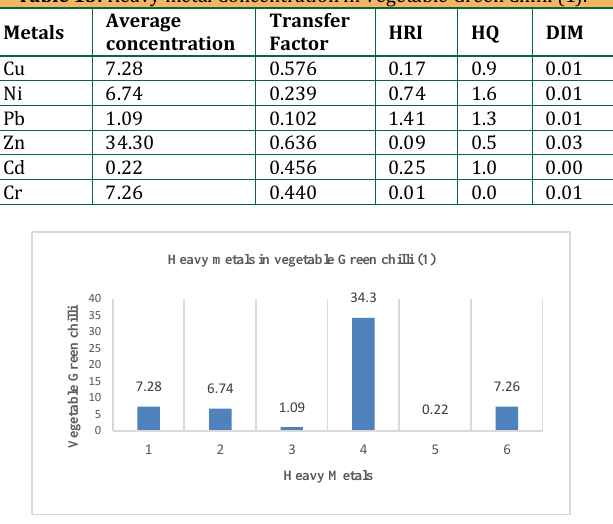
Figure 10: Average Concentration in vegetable Green chilli (1)